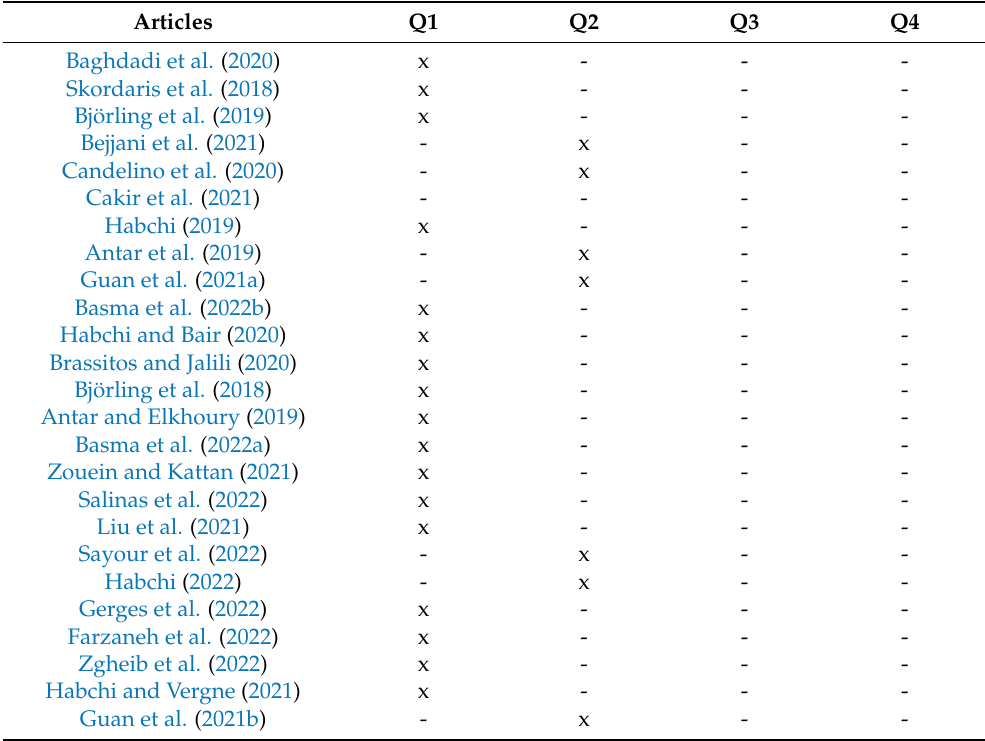
Table A3. Published papers in the School of Engineering per quartile, 2018–2022.